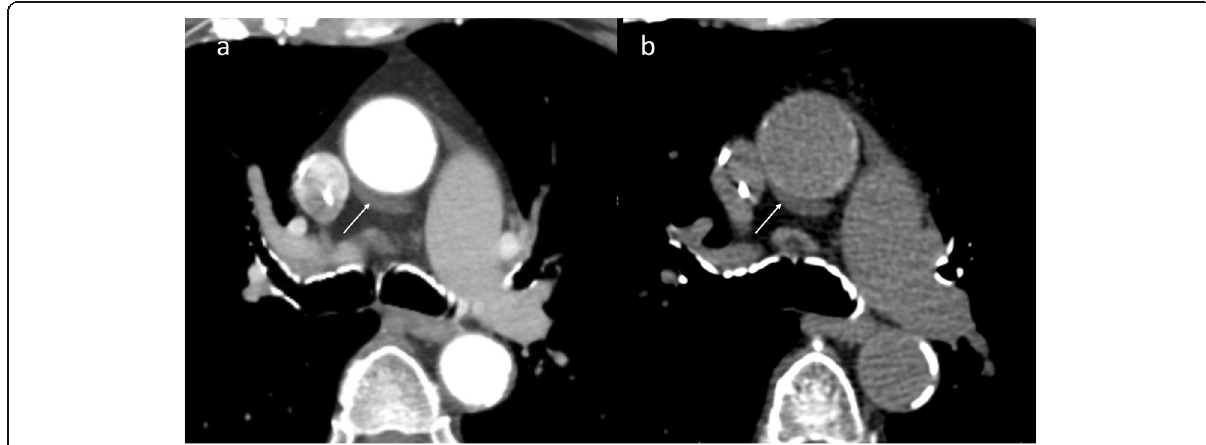
Fig. 15 A 65-year-old male with acute chest pain. Contrast enhanced axial CTA ( a ) image shows asymmetrical hypodensity adjacent to right lateral wall of ascending aorta (arrow). Non-contrast CT ( b ) confirmed hypodense fluid attenuation consistent with superior pericardial recess; potential mimic of intramural hematoma